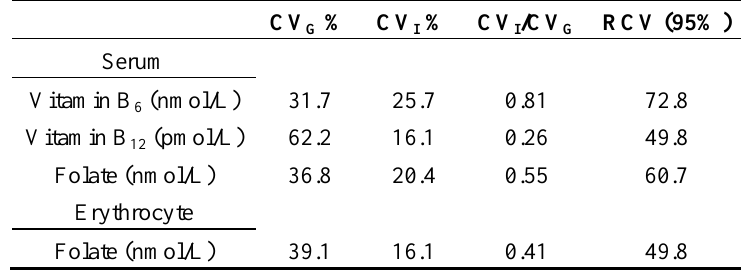
Table 1. CV folate ( n =